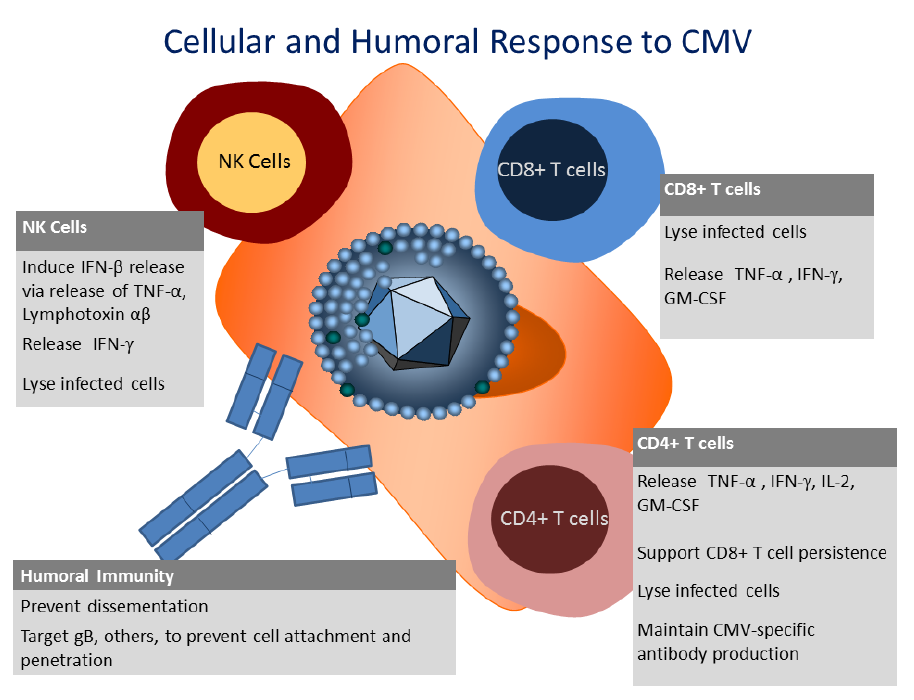
Figure 1. Cellular and humoral immunity to